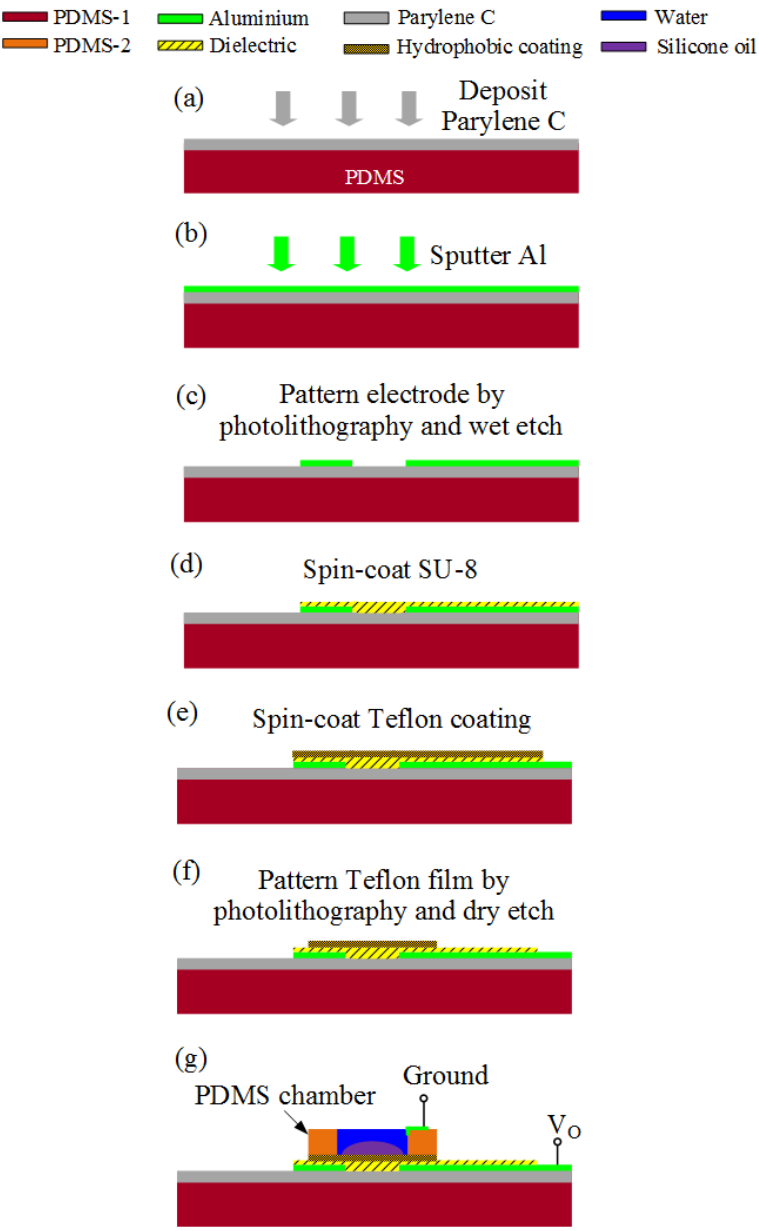
Figure 2. Fabrication process of the flexible electrowetting on dielectric (EWOD) microlens. ( a ) Deposit parylene C layer (~2 µm) on PDMS substrate. Parylene strengthens the boding between PDMS and electrodes; ( b ) and ( c ) sputter aluminum electrode (~200 nm) and pattern it by photolithography and wet etch; ( d ) spin-coat SU-8 dielectric layer (~2.4 µm) and post-bake it at 120 °C for 5 h; ( e ) spin-coat Teflon hydrophobic thin film (~400 nm) and post-bake it at 120 °C for 10 h to remove the solvent; ( f ) sattern the Teflon coating with photolithography and reactive ion etching; ( g ) sond a PDMS chamber onto the substrate using a flexible, UV-cure